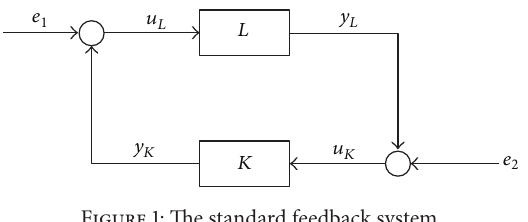
Figure 1: The standard feedback system.